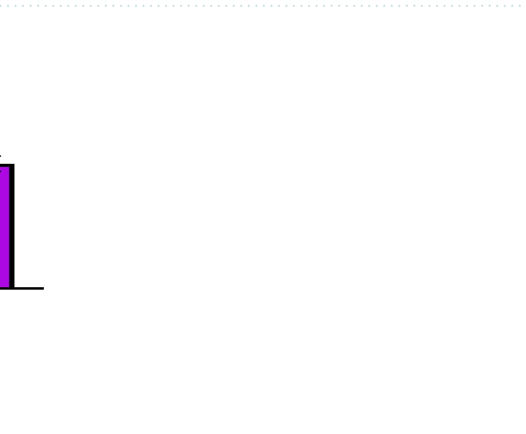
Figure 6. Impact of gallic acid on brain NO level in CdCl 2 -induced neurotoxicity in Wistar rats. The data is represented as mean ± SD (n = 5). # Significant at p < 0.05 compared to the control; *Significant at p < 0.05 compared to CdCl 2 alone group.